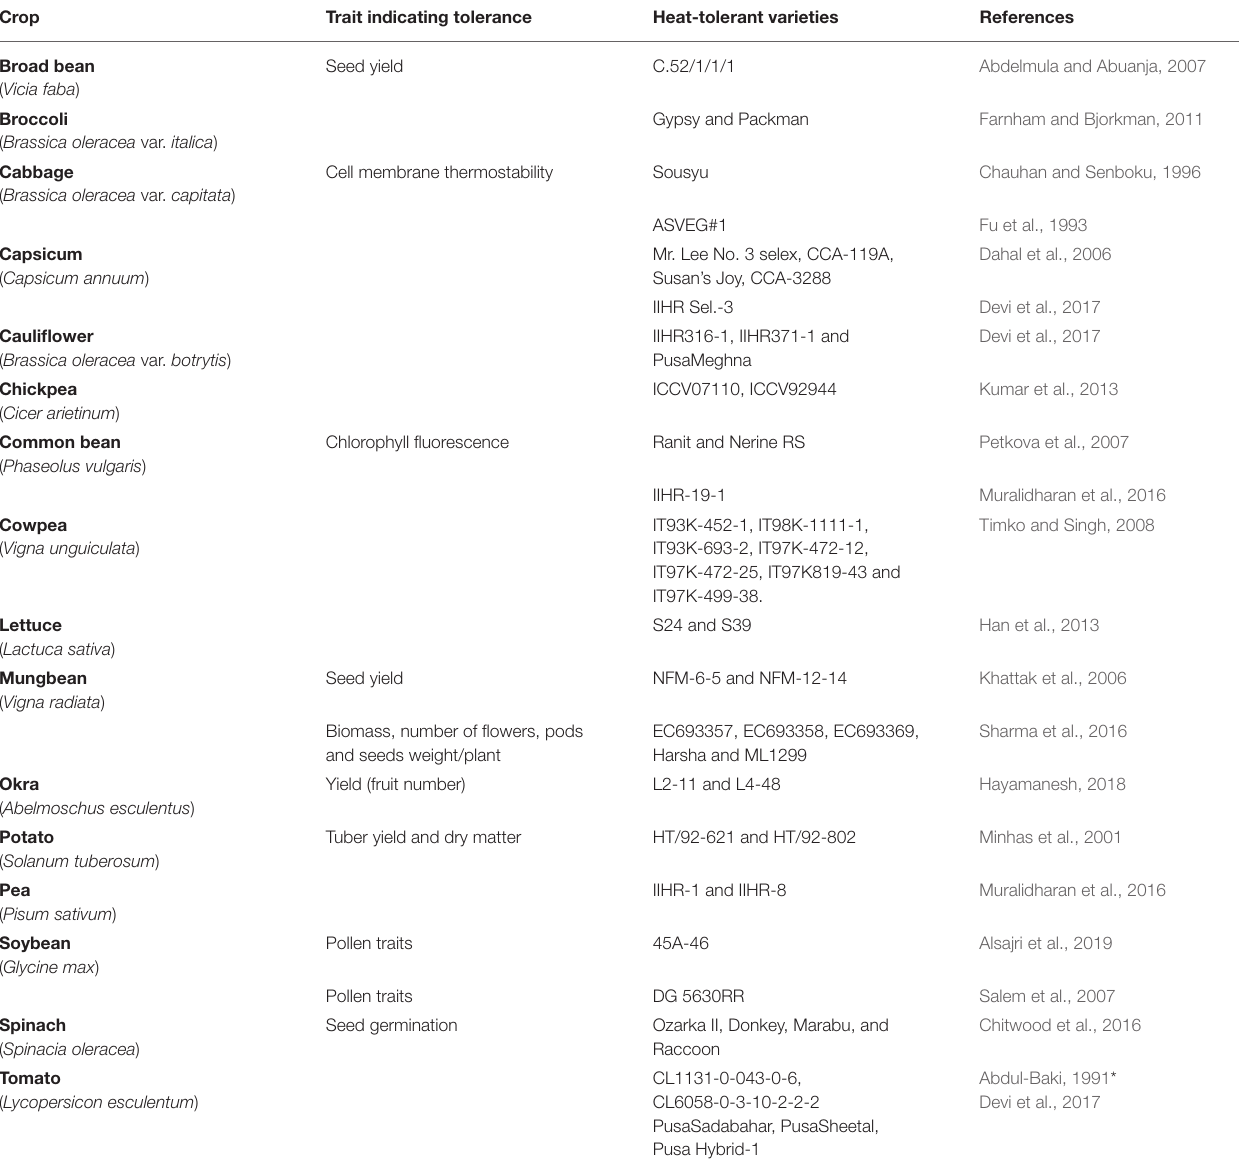
TABLE 6 | Heat-tolerant varieties of some vegetable